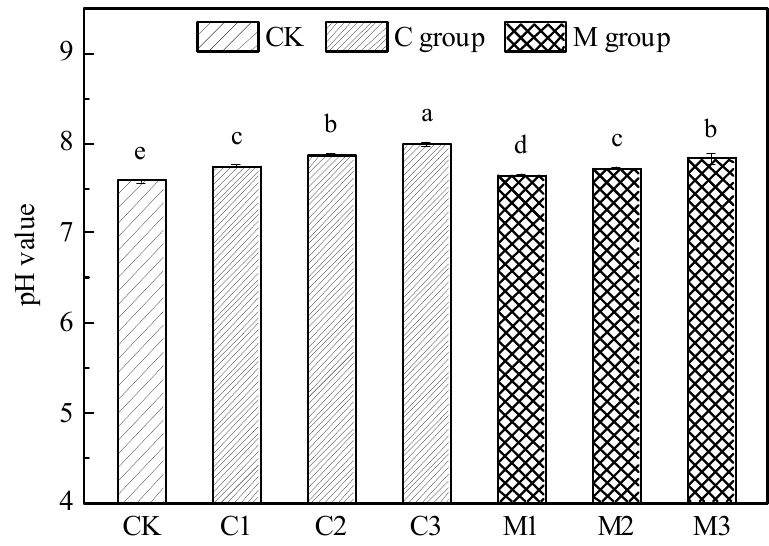
Figure 1. pH value in tailings treated with modifier.